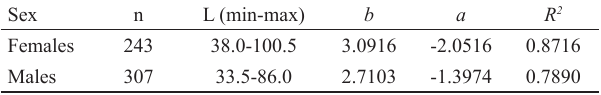
Fig. 3. Frequency distribution of Salminus brasiliensis population by length classes (bars) and grouped by sex (lines). From the Upper Uruguay River between April 1996 and February 2014. Tab. 1. The weight/length relationship for females and males of Salminus brasiliensis in the Upper Uruguay River Basin. Between April 1996 and February 2014. n = sample size, L = total length (cm).